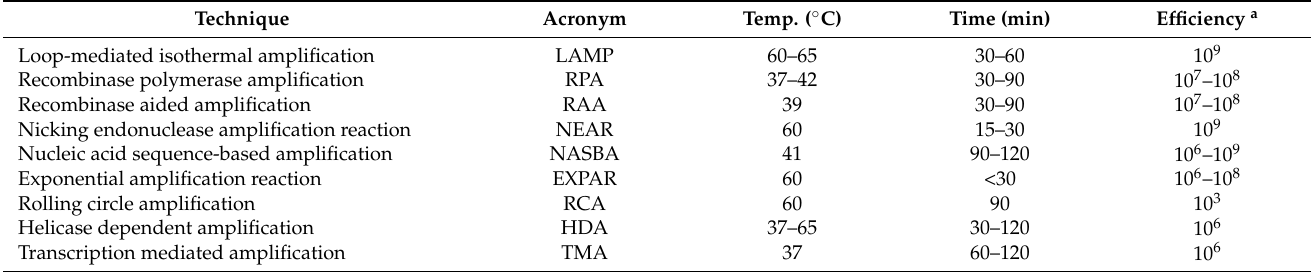
Table 2. Comparison of the main characteristics of isothermal nucleic acid amplification techniques used for SARS-CoV-2 detection. Data from